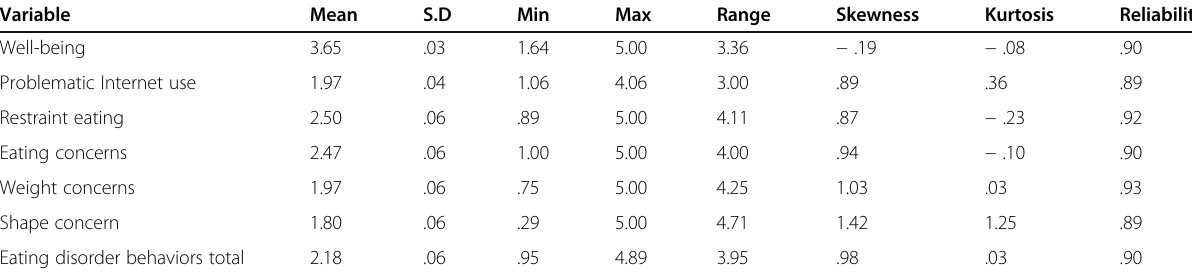
Table 1 Means and standard deviations for research variables ( N = 566) Variable